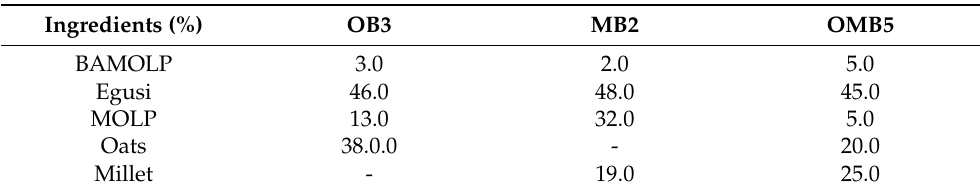
Table 3. Formulation of three varieties of BAMOnut-Bar. Ingredients